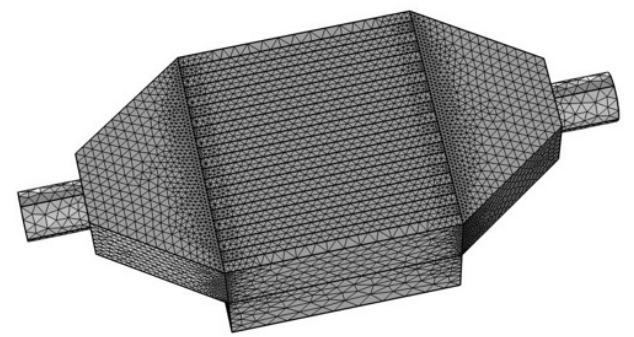
Figure 2. Finite element analysis